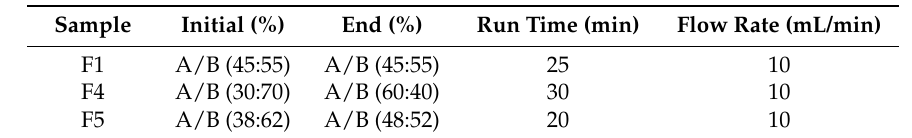
Table 3. Processing conditions for the preparative HPLC separations of sub-fractions F1, F4 and F5. (A: MeOH, B: 0.3% acetic acid in water, v/v ).